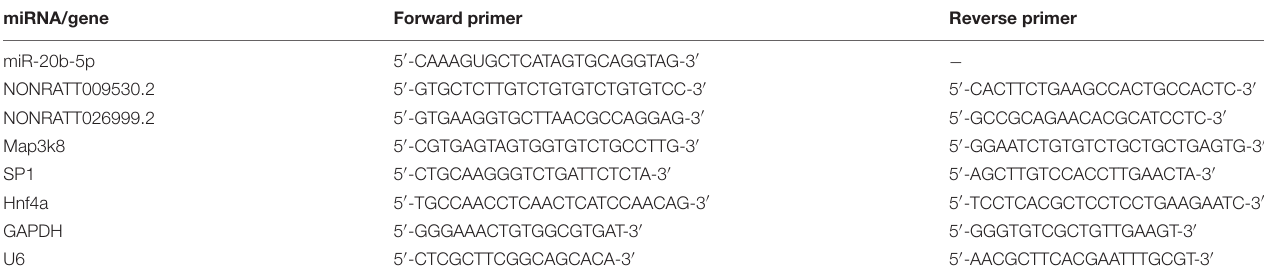
TABLE 1 | qRT-PCR primers sequences used in this study. miRNA/gene